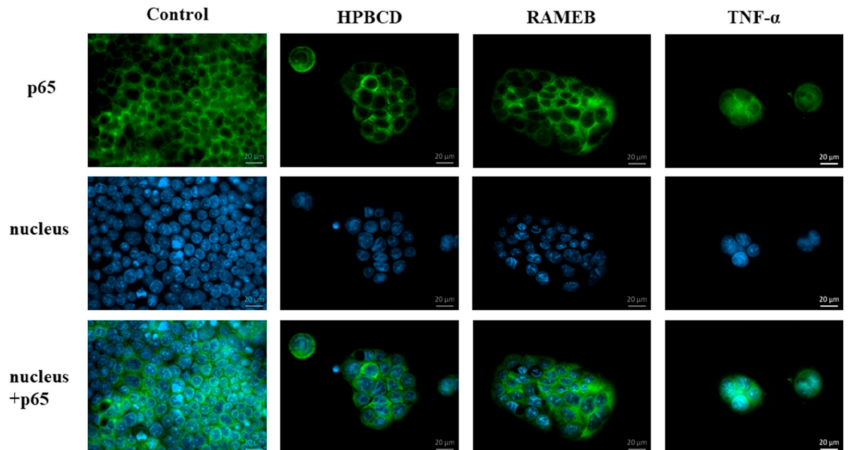
Figure 5. Fluorescence microscopic images of Caco-2 cells after NF-kappa B pathway investigation. HPBCD and RAMEB pre-treatment did not active the translocation of the p65 subunit of the NF- κ B heterodimer into the cell nuclei from the cytoplasm, similar to the control sample. Nevertheless, TNF- α activated the translocation. (Green- p65 subunit, blue-cell